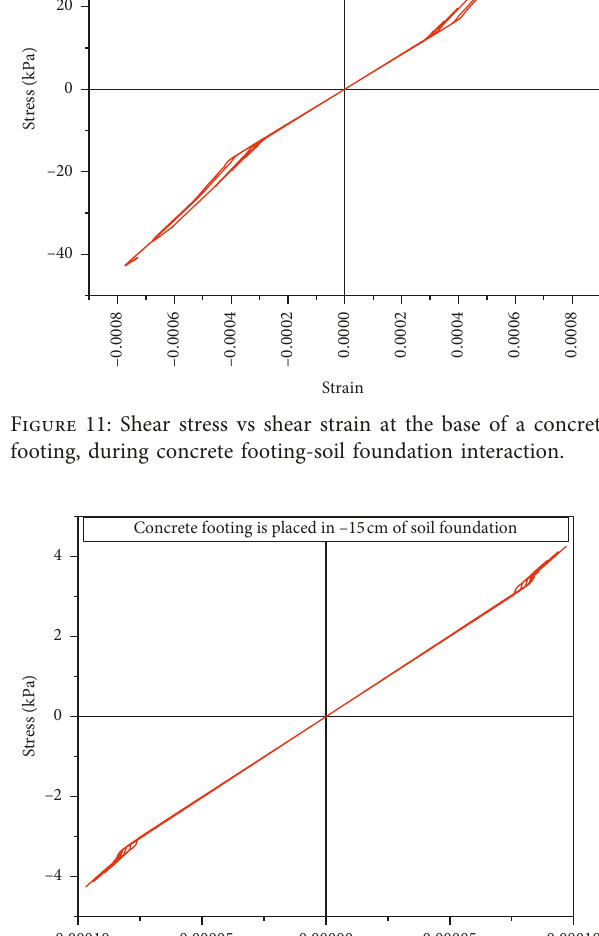
Figure 10: Seismic acceleration load response vs strain at the base of a concrete footing, during concrete footing-soil foundation interaction. Figure 12: Shear stress vs shear strain at the base of a concrete footing, during concrete footing-soil foundation interaction.